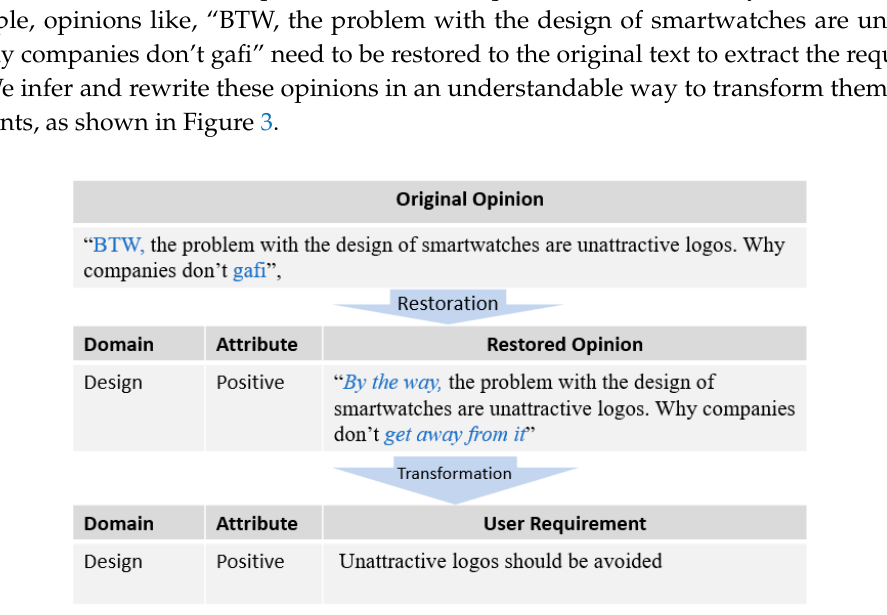
Figure 3. Example of restoration and transformation of collected opinions .